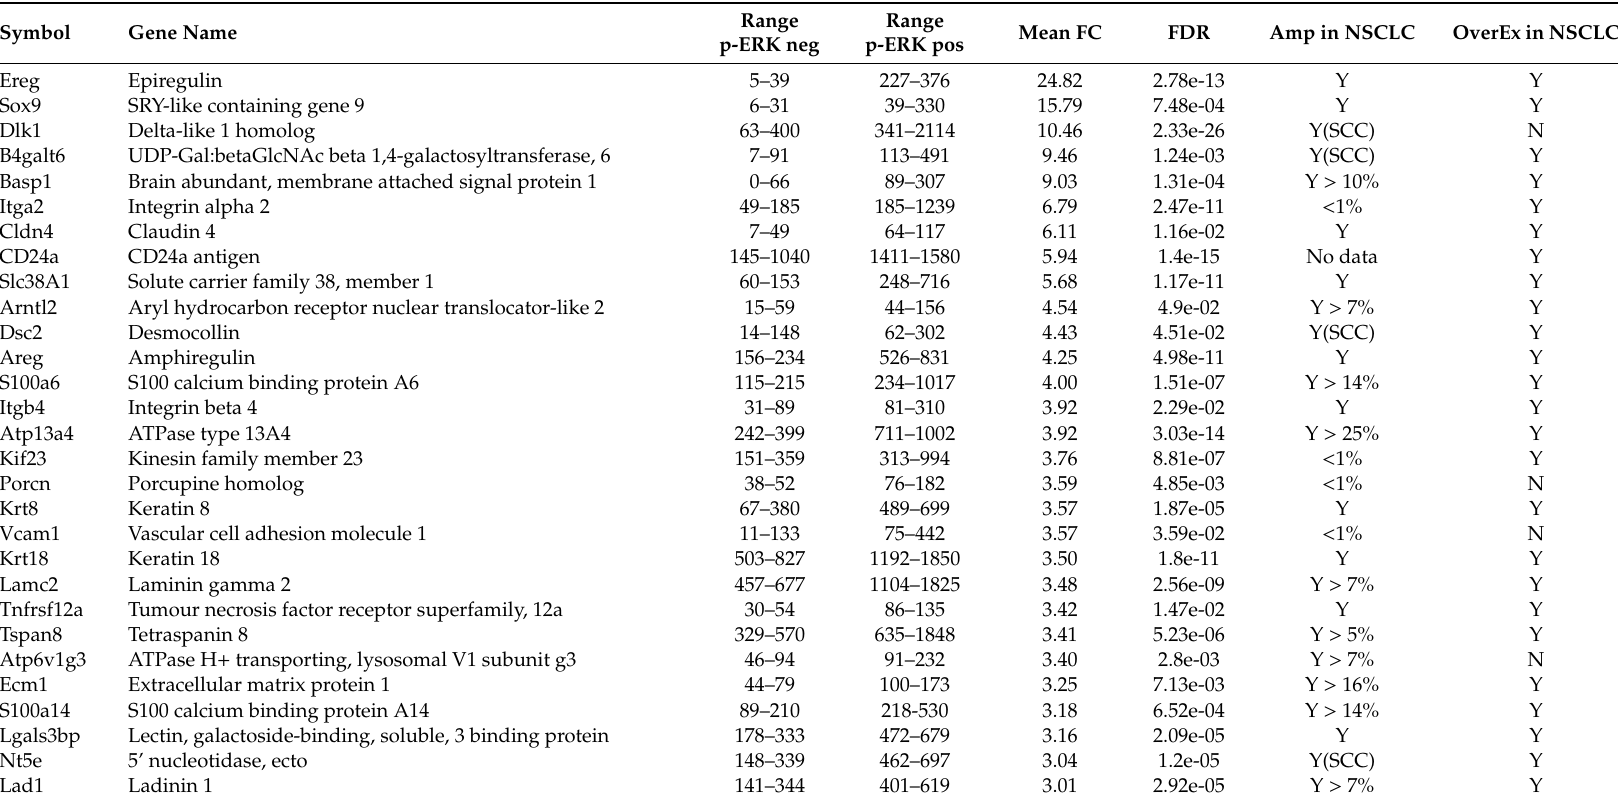
Table 1. Specific genes upregulated in pErk High KM tumour regions. Genes were selected based on evidence of overexpression and / or amplification in human non-small cell lung cancer (NSCLC). Range of RNA-SEQ read count values, normalised for total reads per sample, for the indicated genes. FC = fold change. FDR = false discovery rate. Amp = Amplified. OverEx = Overexpressed. For “Amplified in human NSCLC”: Y = yes (1–5%) with > 5% and < 1% where noted; N = No; SCC = squamous cell carcinoma where noted, otherwise adenocarcinoma or unclassified. For “Overexpressed in human NSCLC”: Y = Yes; N =